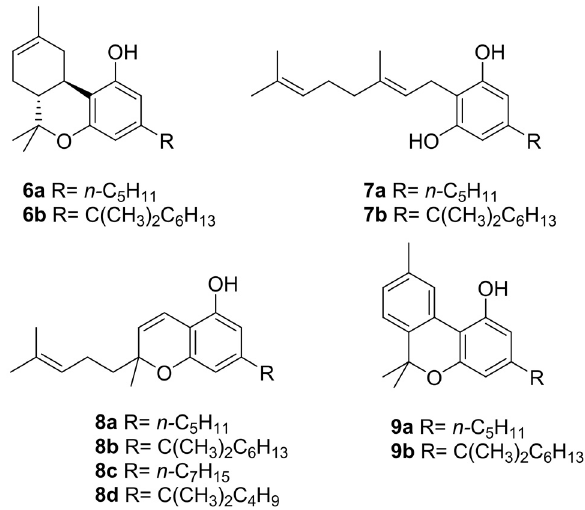
Figure 2. Structure of major phytocannabinoids ∆ 8 -THC ( 6a ), CBG ( 7a ), CBC ( 8a ), and CBN ( 9a ) and their α , α -dimethylheptyl analogues ( 6b – 9b